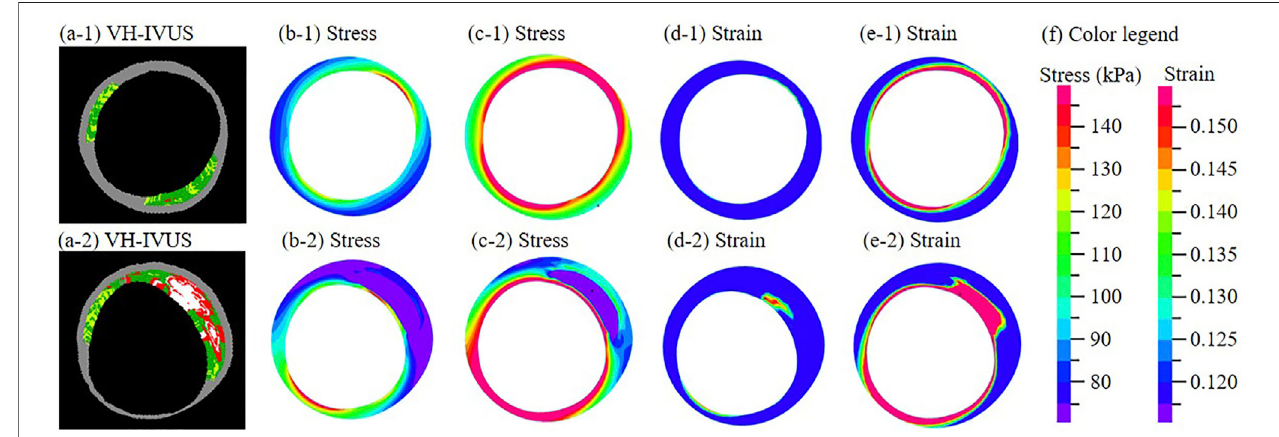
FIGURE 1 | (a-1) – (a-2) One paired VH-IVUS images from the same location at baseline (a-1) and follow-up (a-2) . (b-1) − (b-2) Stress distribution of the thin-slice modelatminimumpressure. (c-1) − (c-2) Stressdistributionatmaximumpressure. (d-1) − (d-2) Straindistributionatminimumpressure. (e-1) − (e-2)